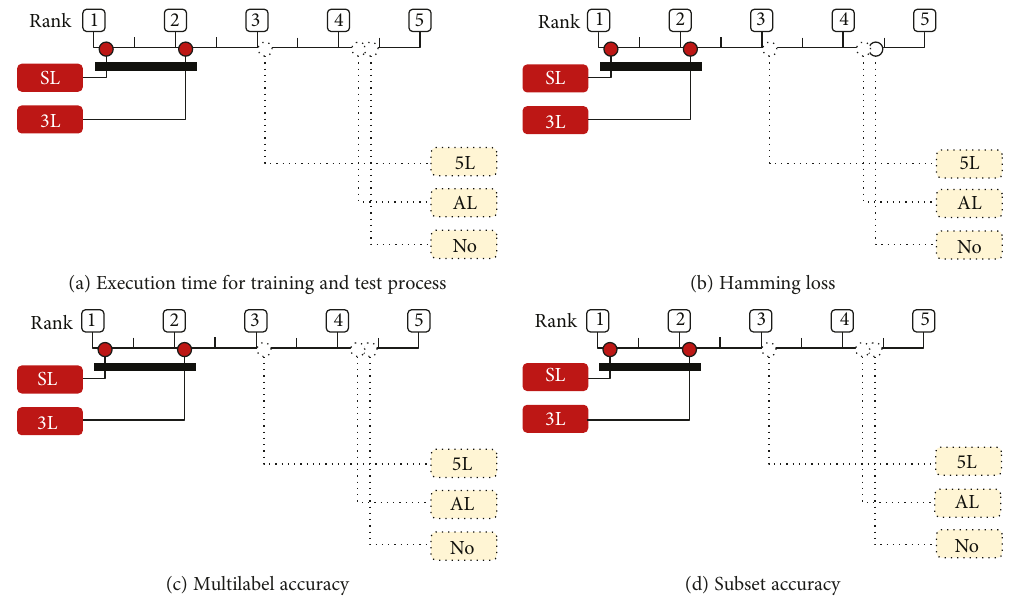
Figure 7: Bonferroni-Dunn test results of fi ve comparing methods with four evaluation measures. Methods not connected with the best method in the CD diagram are considered to have signi fi cantly di ff erent performance (signi fi cance level α = 0 05 ). This is reproduced from Lee et al. (2017) (under the Creative Commons Attribution License/public domain). Table 7: Comparison results of proposed method, MLCFS, and PPT+ RF on the Delicious dataset.